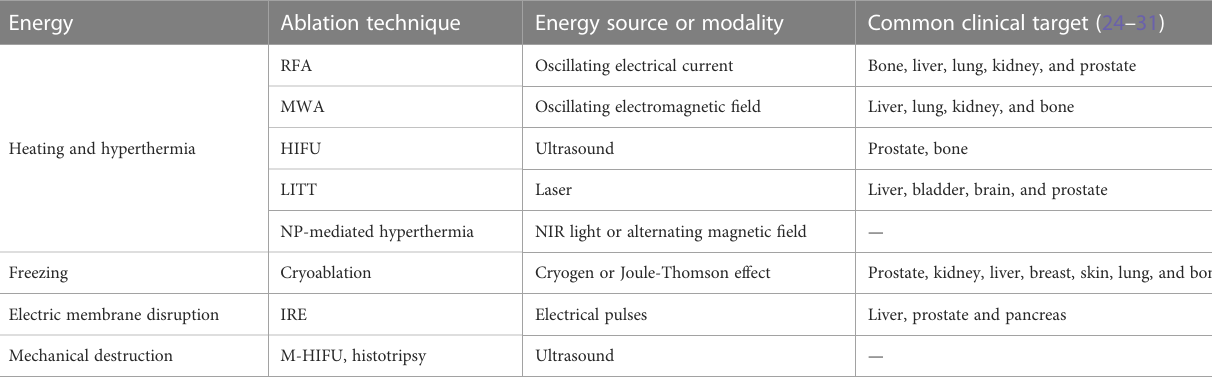
TABLE 2 Overview of energy-based focal ablative techniques.